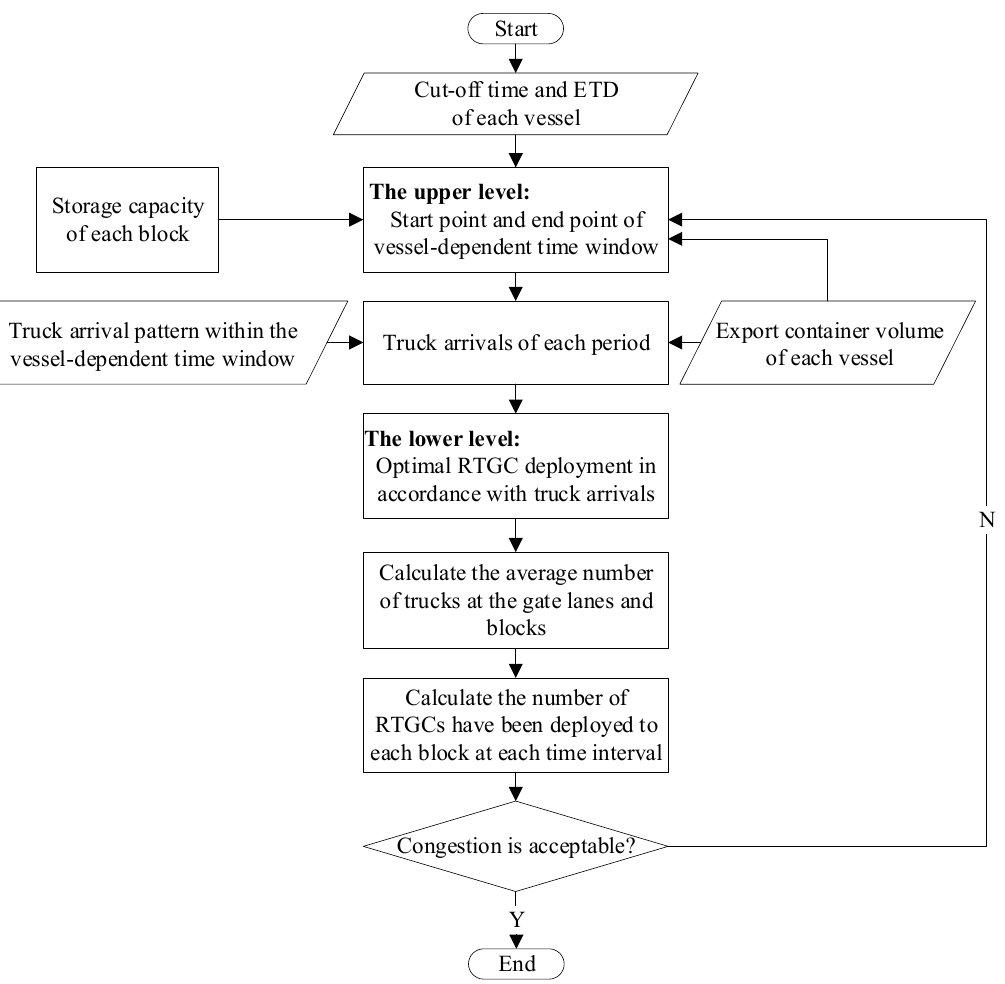
Figure 2. The framework of VDTW assignment and RTGC